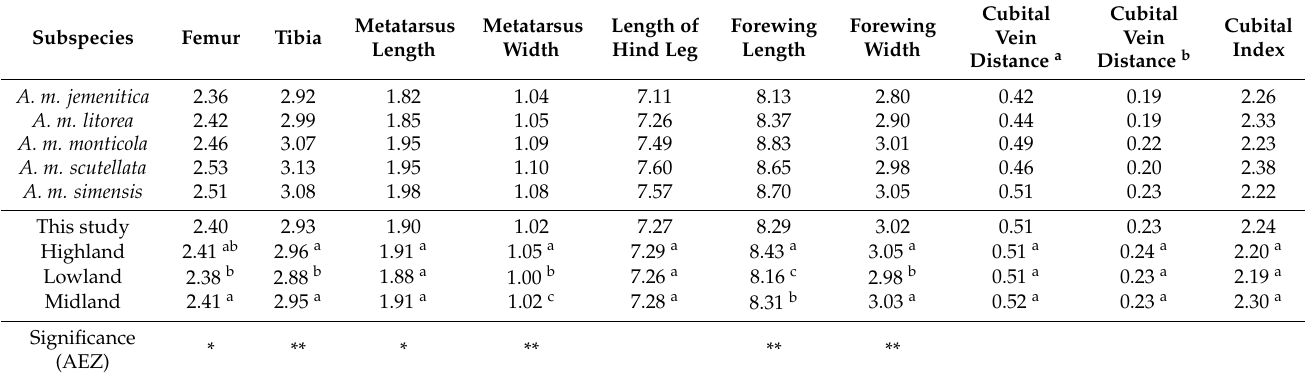
Table 1. Mean values (mm) of morphometric characteristics of size in this study’s samples and the reference subspecies obtained from the Oberursel Bee Research Institute (Germany). The lower table shows morphometric means of highland, lowland and midland ecotypes of this study and the statistical significance of agro-ecological zone (AEZ) within the Ethiopian